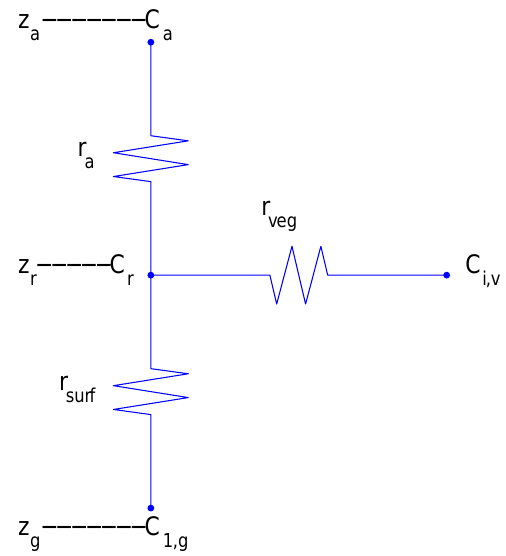
Fig. 3. The relationship between gas concentrations at different lev- els (i.e., z g is the center of the top soil control volume, z r is the apparent sink level, and z a is the atmosphere reference height) and their relevant resistances. The relationships are explained in